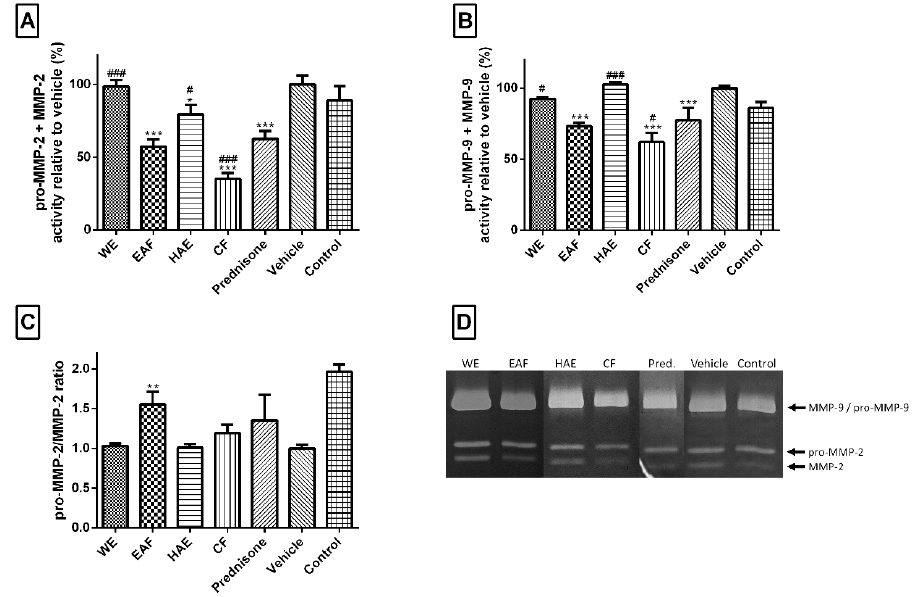
Figure 7. Effects of the tested A. wilhelmsii extracts and fractions and the reference drug prednisone, on TNF- α secretion. Cells were pre-treated with the given extracts and fractions (25 µg/mL), prednisone (1 µM) or the vehicle (DMSO) only. After 1 h of incubation, the inflammatory response was induced by the addition of lipopolysaccharide (LPS) (except for the control cells). Results are expressed as means ± SD for three independent experiments. * Significant difference in comparison to vehicle-treated cells ( p < 0.05); *** significant difference in comparison to vehicle-treated cells ( p < 0.001); # significant difference in comparison to prednisone-treated cells ( p < 0.05); ### significant difference in comparison to prednisone-treated cells ( p < 0.001).